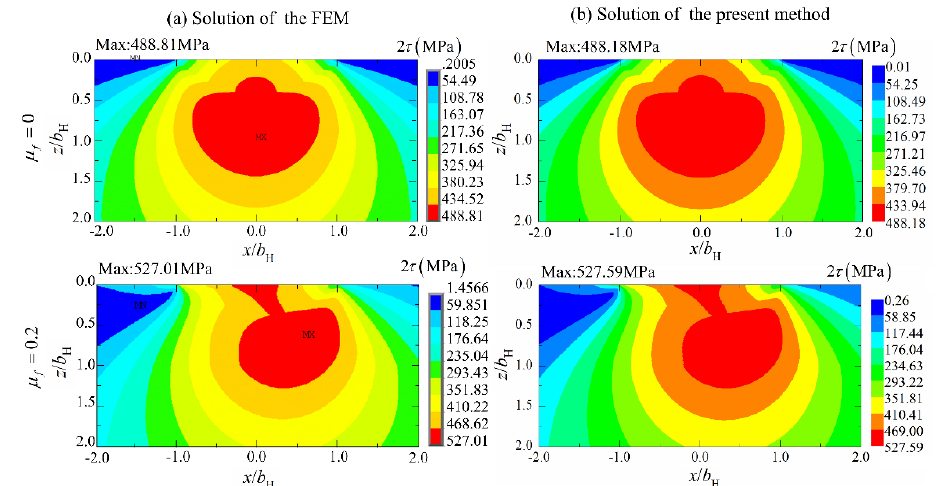
Figure 4. Comparison of the maximum shear stress of a multilayered half plane with 40 layers subjected to surface contact loading, ( a ) the solution of FEM, ( b ) the solution of the present method.